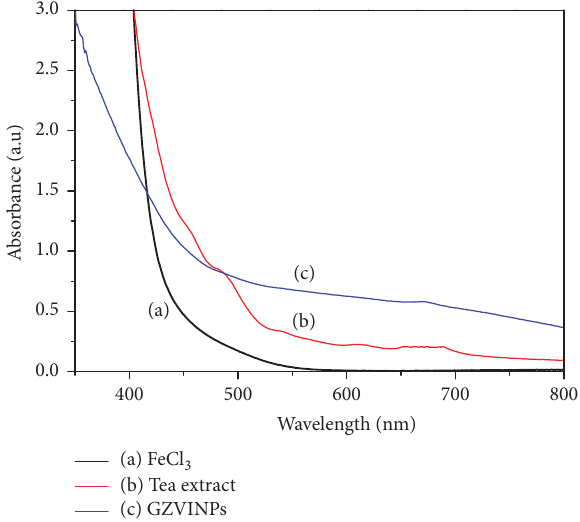
Figure 1: The UV spectra of (a) FeCl 3 , (b) tea extract, and (c)